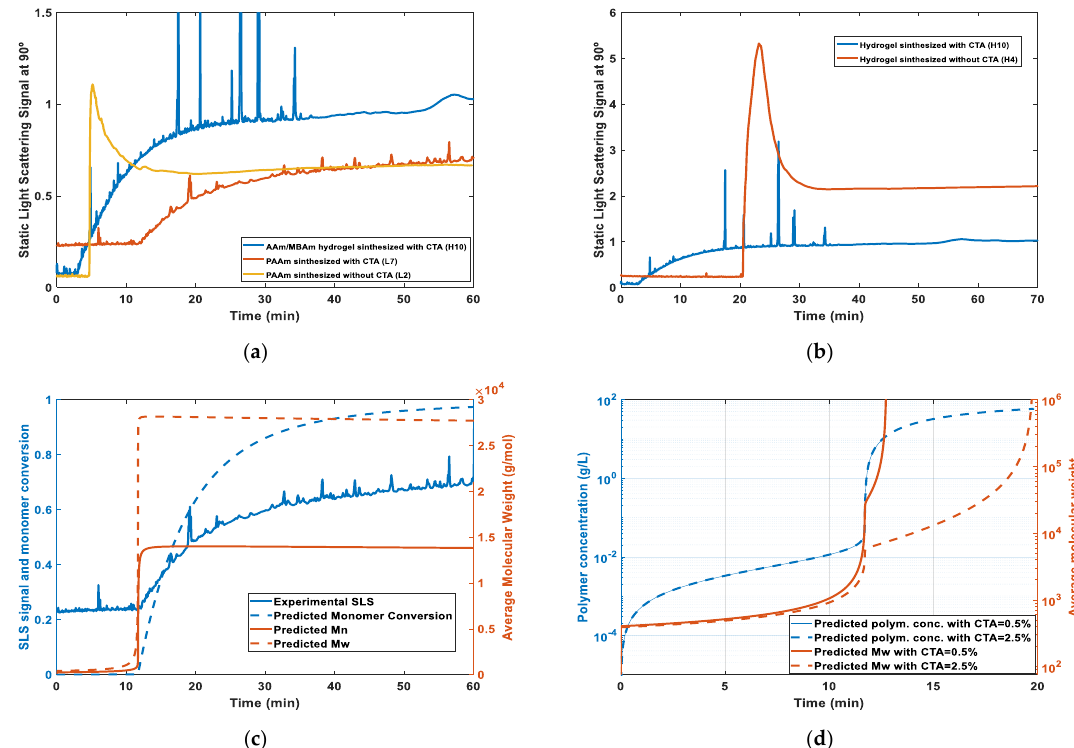
Figure 15. ( a , b ) In-line measured SLS signal for polymerization runs involving the use of a CTA and their comparison with experiments without CTA. ( c ) Predicted time-evolution of monomer conversion and weight-average molecular weights ( 𝑀̅ 𝑛 and 𝑀̅ 𝑤 ) during PAAm synthesis in the presence of a chain transfer agent ( 𝑇 = 26 ° C, APS/TEMED, 𝑌 𝑀 = 9%, 𝑌 𝐼 = 0.2%, and 𝑌 𝐶𝑇𝐴/𝑀 = 0.5%). ( d ) Predicted polymer concentration and 𝑀̅ 𝑤 corresponding to AAm/MBAm hydrogel synthesis in the presence of a chain transfer agent. Two different CTA concentrations were considered, 𝑌 𝐶𝑇𝐴/𝑀 = 0.5% and 𝑌 𝐶𝑇𝐴/𝑀 = 2.5%, with 𝑌 𝑀 = 9% and 𝑌 𝐼 = 0.2%.